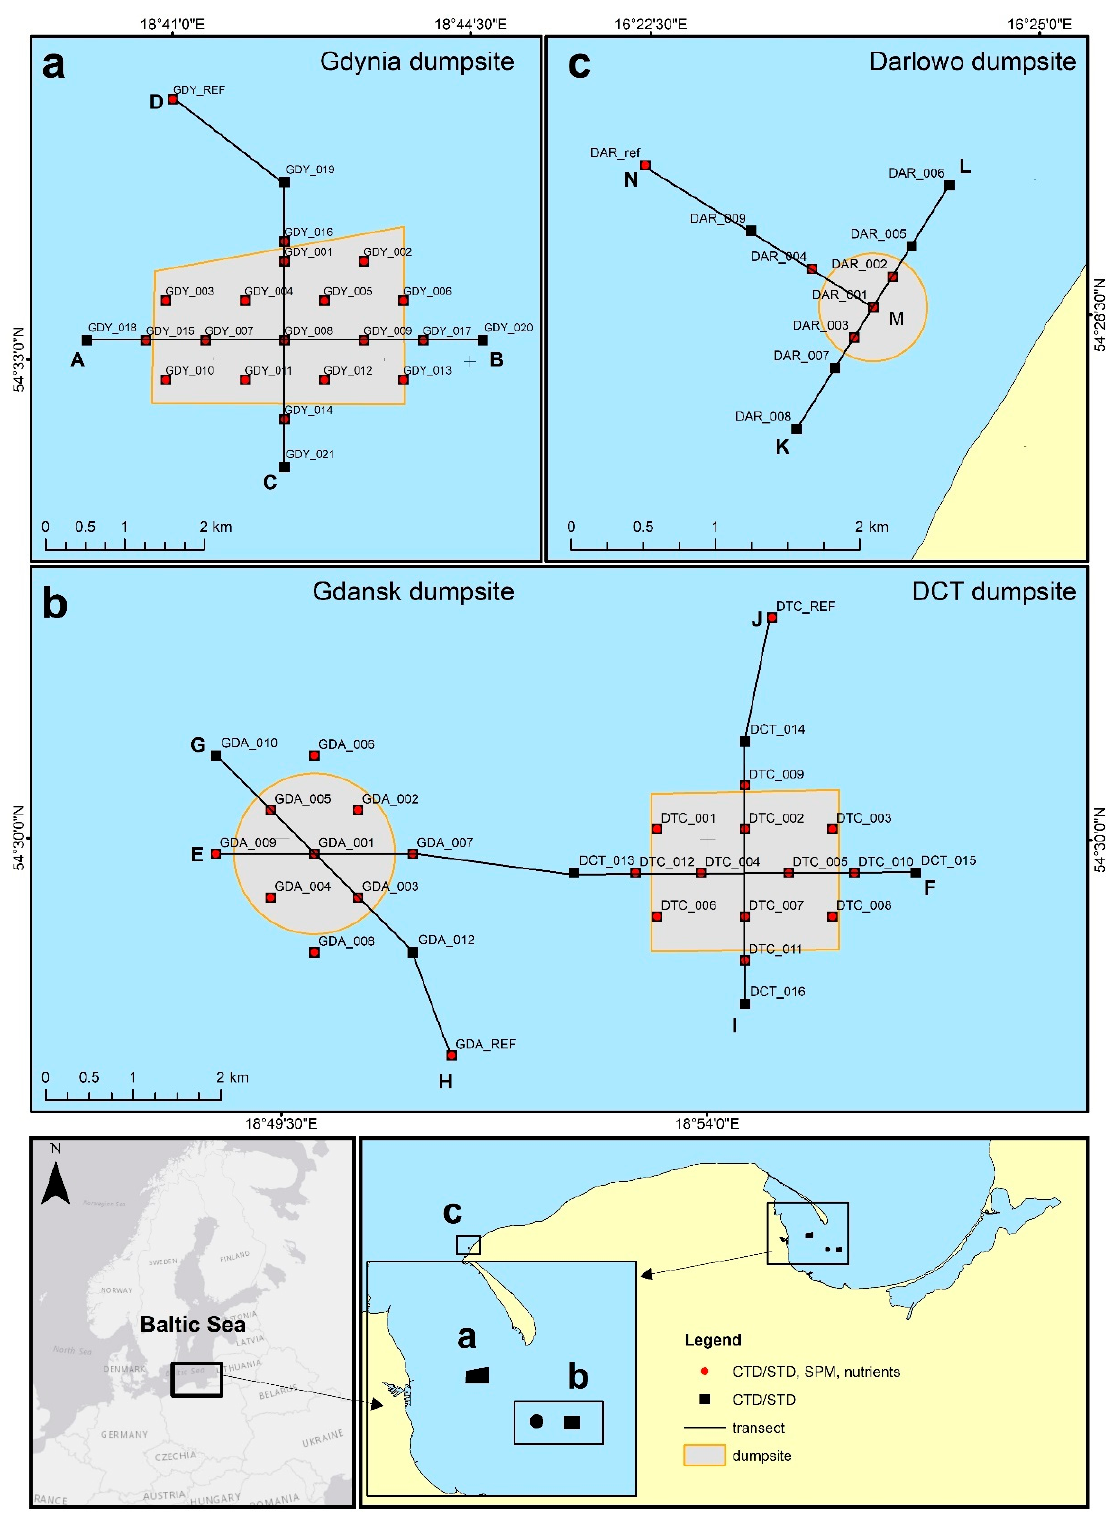
Figure 1. Map of the study sites, with the survey transects and the sampling points marked by red and black dots.